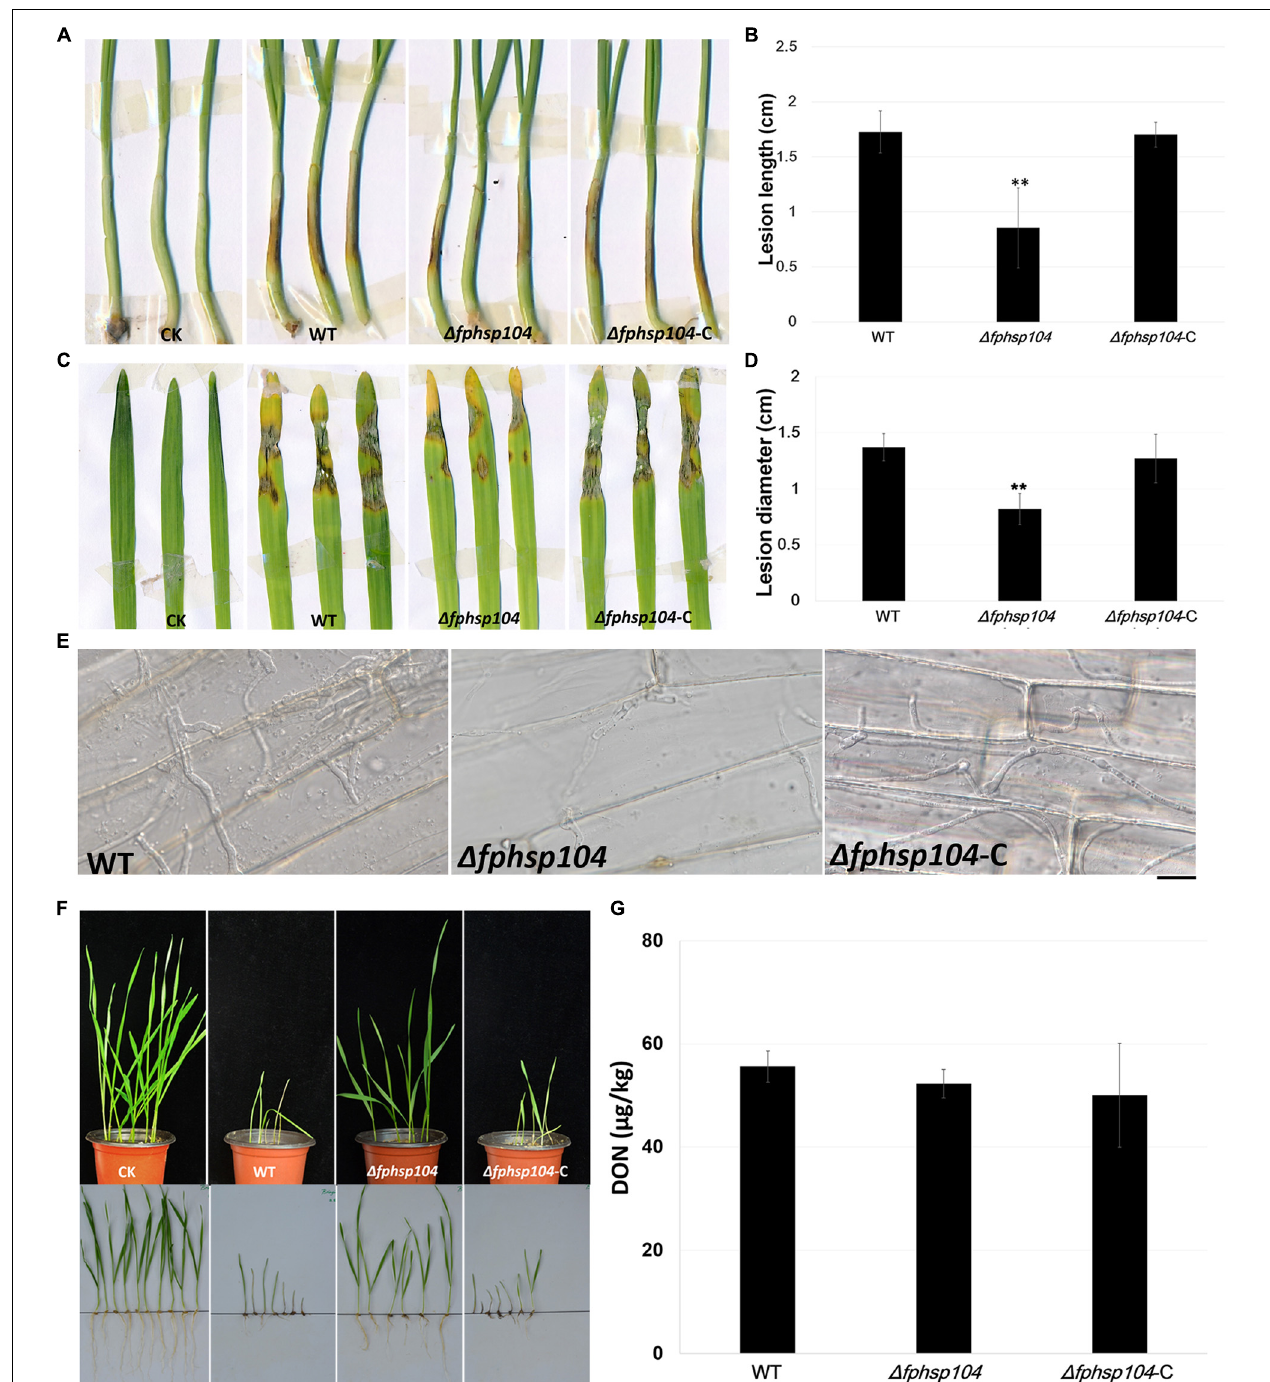
FIGURE 8 | Pathogenicity and DON assays. (A) Wheat coleoptiles were inoculated with mycelial blocks of wild-type (WT), (cid:49) fphsp104 , and (cid:49) fphsp104 -C strains. Agar blocks without mycelia inoculated wheat as blank control (CK). (B) Statistical analyses of lesion lengths from the infected wheat coleoptiles. Bars represent standard deviation (SD) of three independent experiments. ∗∗ p < 0.01 ( t -test). (C) Barley leaves were inoculated with mycelial blocks of WT, (cid:49) fphsp104 , and (cid:49) fphsp104 -C strains. Agar blocks without mycelia inoculated barley as blank control (CK). (D) Statistical analyses of lesion diameters from the infected barley leaves. Bars represent SD of three independent experiments. ∗∗ p < 0.01 ( t -test). (E) Wheat coleoptiles from 4-day-old wheat seedlings were inoculated with mycelial blocks. Infectious growth was observed 4 days after inoculation. Bar = 20 µ m. (F) Wheat seeds were inoculated with WT, (cid:49) fphsp104 , and (cid:49) fphsp104 -C strains and cultured at 25 ◦ C for 7 days. Sterile millet was used as blank control (CK). (G) DON production in WT, (cid:49) fphsp104 , and (cid:49) fphsp104 -C strains was tested using ELISA assays.